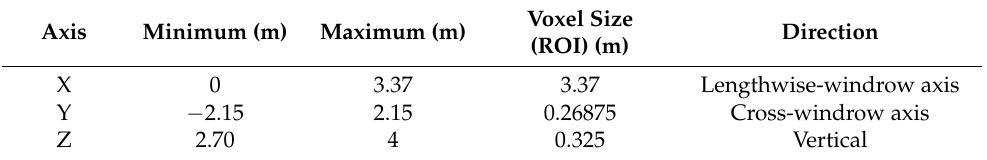
Table 2. 3D ToF camera calibration values. ROI: Region of